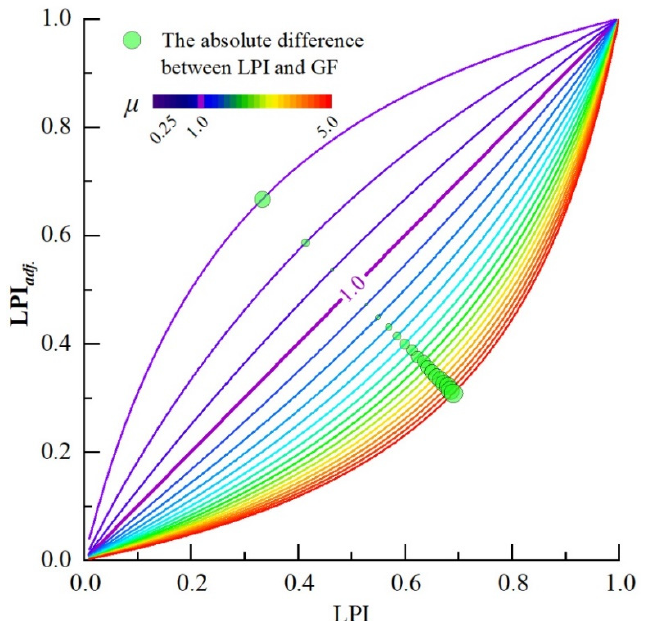
Figure 3. Effect of μ on LPIs. Each circle marks the position of the largest difference between LPIs and (cid:1838)(cid:1842)(cid:1835) (cid:3028)(cid:3031)(cid:3037). under different μ values. The size of the circle represents the absolute difference be- and LPI adj . under different µ values. The size of the circle represents the absolute difference between tween LPIs and (cid:1838)(cid:1842)(cid:1835) (cid:3028)(cid:3031)(cid:3037). . LPIs and LPI adj .